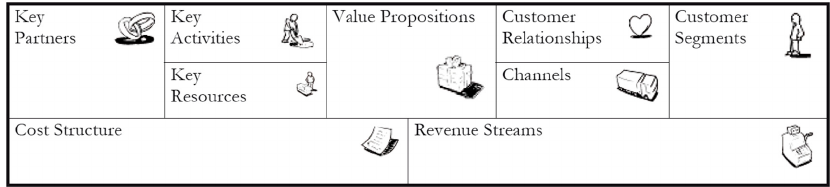
Figure 5. Business model canvas by Osterwalder and Pigneur.